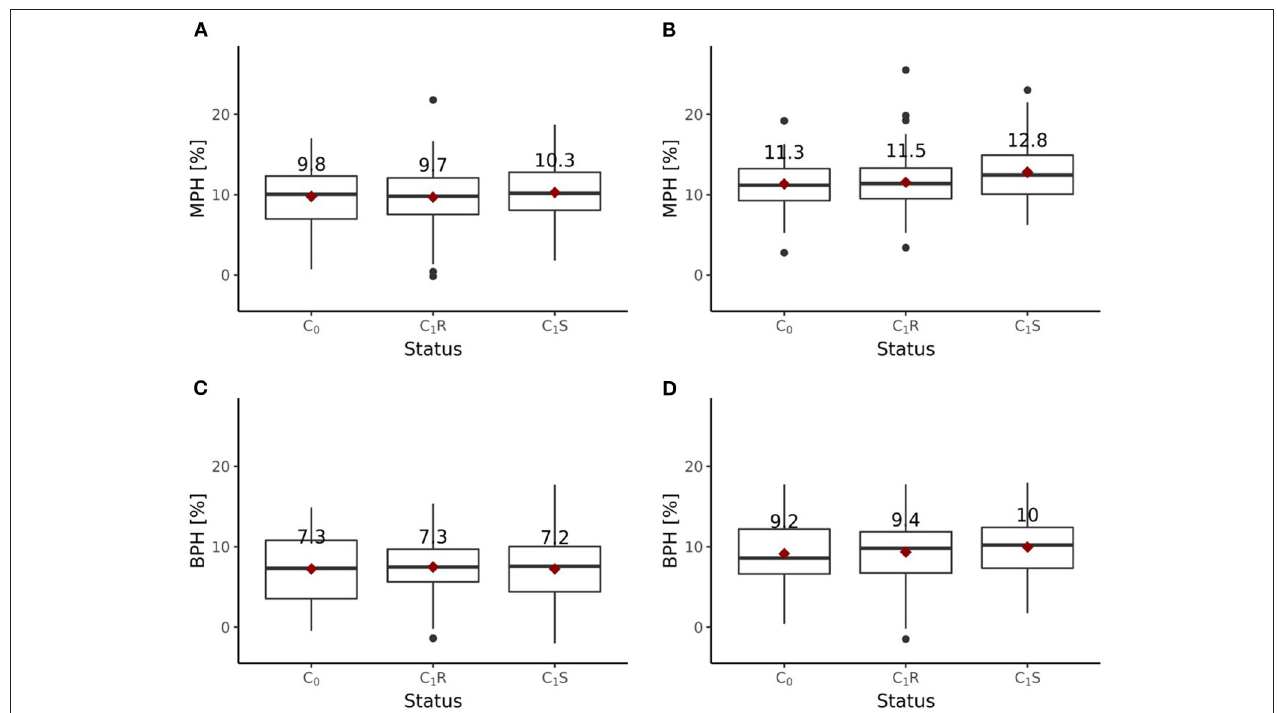
FIGURE 7 | Midparent heterosis (MPH) and better parent heterosis (BPH) for hybrids generated in the reciprocal recurrent selection program. MPH [%] estimated based on trials performed (A) at 6 locations and (B) 4 locations, excluding 2 stress environments. BPH [%] estimated based on trials performed (C) at 6 locations and (D) 4 locations, excluding 2 stress